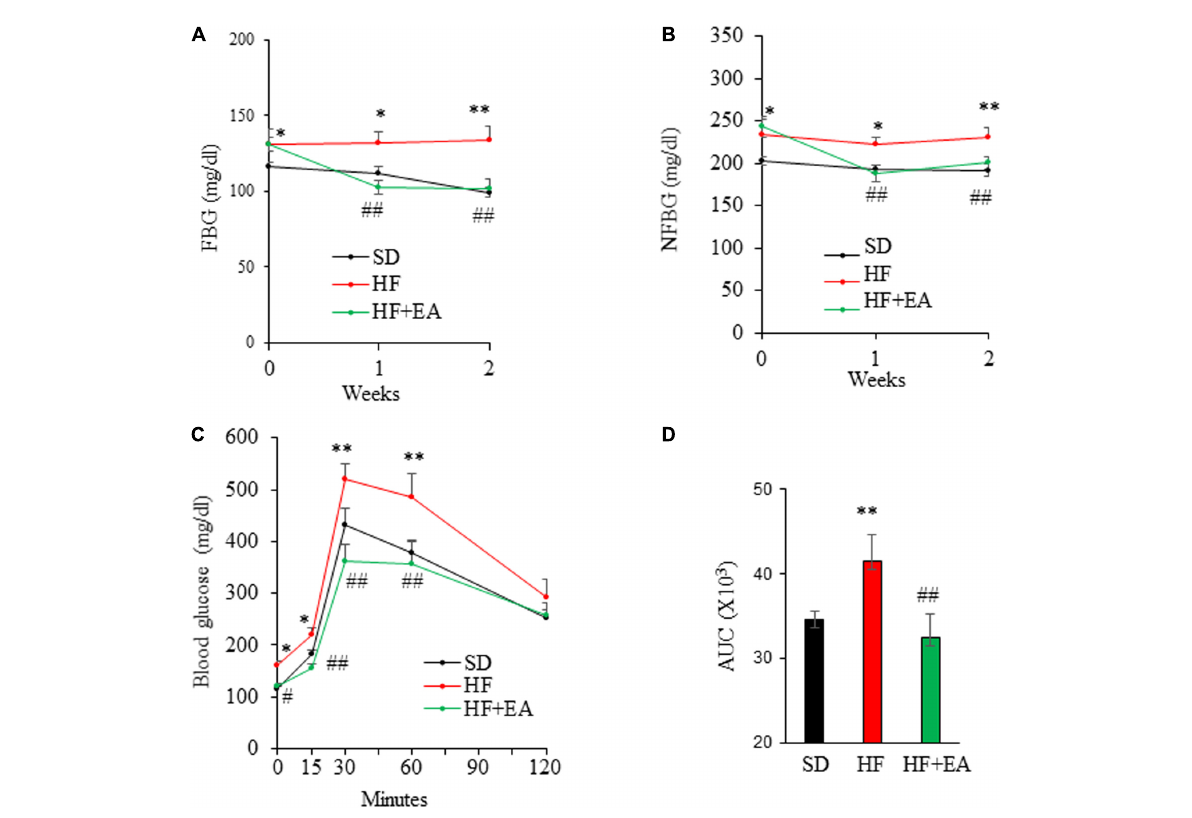
FIGURE4 Elenolic acid (EA) is a potent anti-diabetic agent in high-fat diet (HF)-induced obese mice. C57BL6 mice (8 weeks old, male) were fed either a SD or a HF for 10 weeks, followed by treatment with EA (50 mg/kg/d) or vehicle via oral gavage for 2 weeks. Fasting blood glucose (FBG) (A) and non-fasting blood glucose (NFBG) (B) were measured once per week. Blood glucose levels during IPGTT (1.5 g glucose/kg) (C) and the area under the curve (AUC) was calculated (D) . Data are Mean ± SE ( n = 8). ∗ p < 0.05, and ∗∗ p < 0.01 vs. SD-fed mice; # p < 0.05; and ## p < 0.01 vs. high-fat-diet (HF) alone-fed